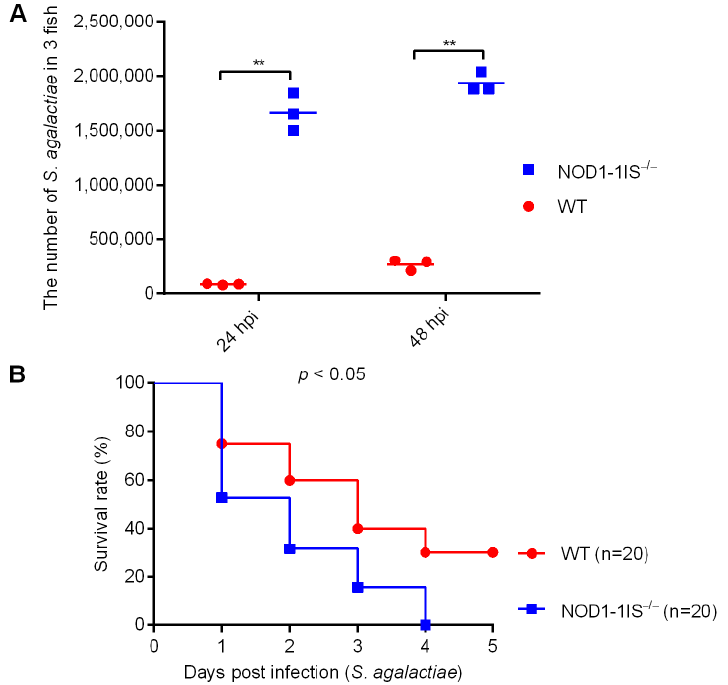
Figure 1. The effect of zebrafish NOD1 in Streptococcus agalactiae infection. ( A ) Effect of NOD1 knockdown on the proliferation of S. agalactiae in the mixture of liver and spleen from zebrafish at the age of 7 months. **, p < 0.01. ( B ) NOD1 − ⁄ − zebrafish were more sensitive to S. agalactiae infection compared with the WT based on the survival rate.